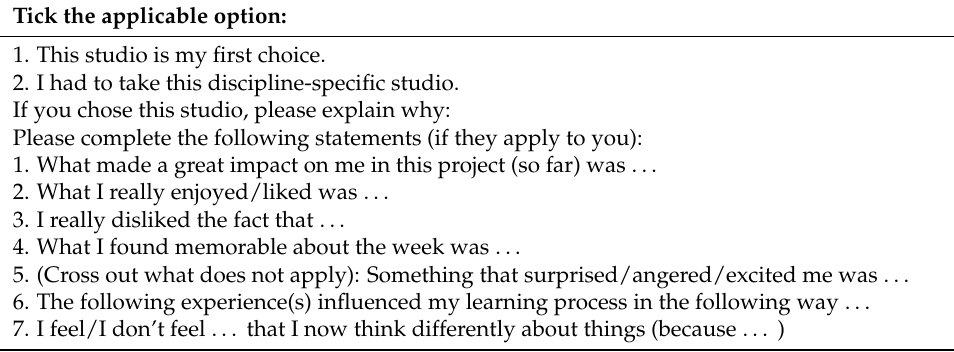
Table 1. Guiding questions contained in the research questionnaires to the